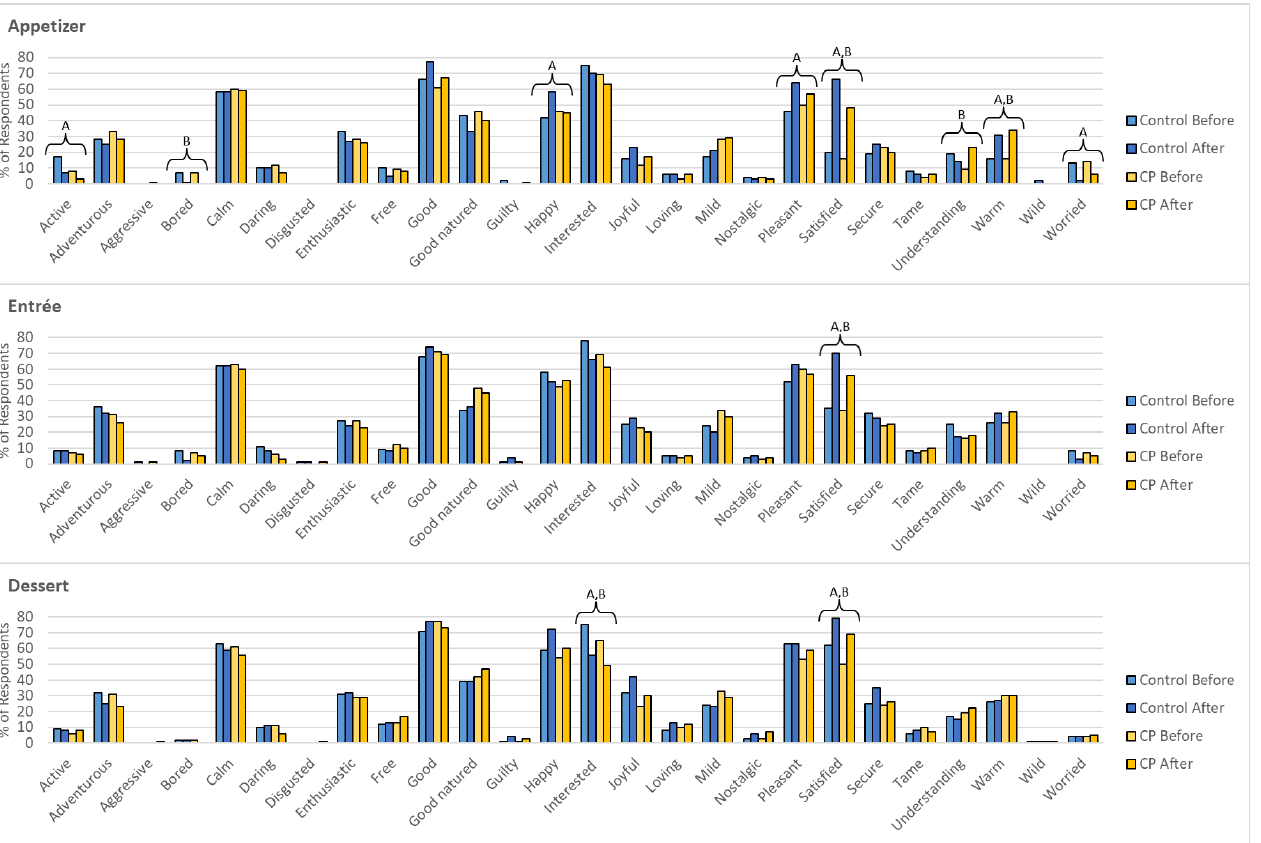
Figure 2. The percentage of participants who selected an emotion term before and after each dish evaluation. Bar graphs were colored blue for the Control dishes ( n = 106) and yellow for the CP dishes ( n = 103). Emotions that were denoted with a number were found to have a significant difference between the percentages of participants who selected the emotion term before and after consumption, using a two-tailed z -test (p < 0.05), for (A) the Control dish and (B) the CP dish. For the entrée, there was a significant increase ( p < 0.05) in the selection of the term satisfied (positive) after consumption for both the Control and CP versions. No change in selection was found for the other emotion terms ( p > 0.05).